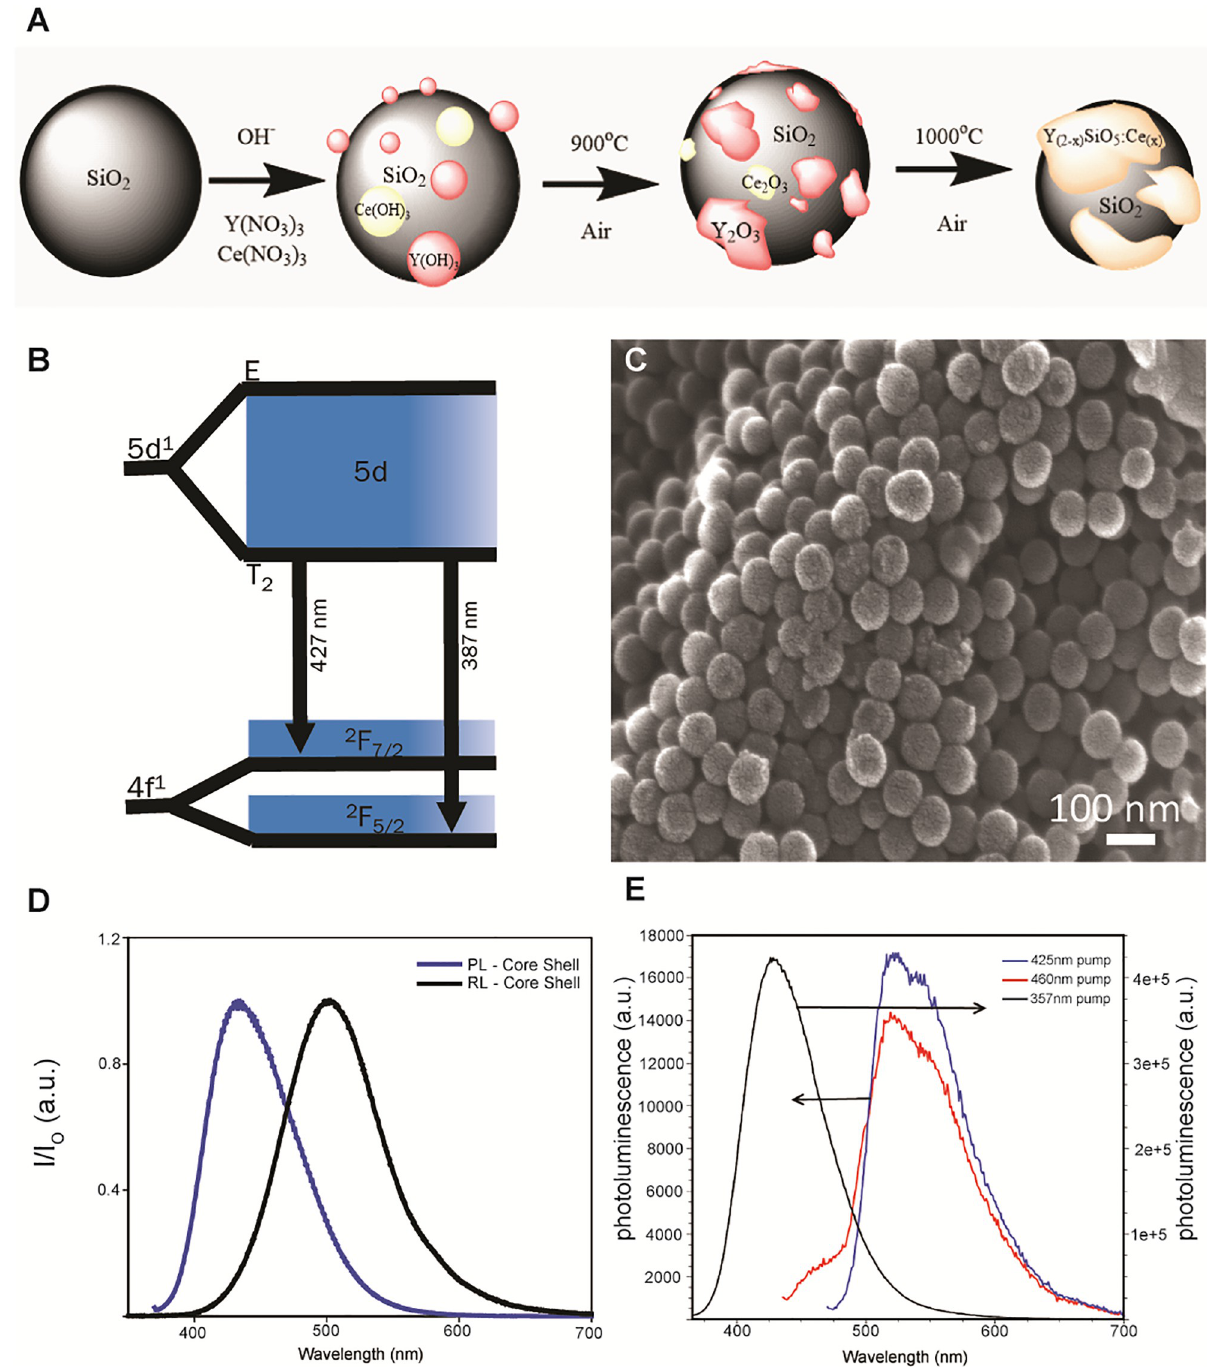
Fig 2. Generation and characterization of radioluminescent particles. A) Schematic of the development of Y2(SiO 4 )O:Ce using a core-shell method. B) Relaxation of cerium from it higher energy 5d state to its respective ground state of 2F7/2 and 2F5/2 in the Ce 1 site. C) Scanning electron micrograph of Y2(SiO 4 )O:Ce nanoparticles synthesized by the Sto¨ber process. D) Photoluminescence and radioluminescence of nano core-shell particulates irradiated by 360 nm and a broadband 40 KeV tungsten x-ray source, respectively. E) Photoluminescence spectra of sub-100 nm Y2(SiO 4 ) O/BSA/fluorescein nanoparticles in 1x PBS. A 100 μ L sample of a 31.4 mg/ml dispersion was placed in 2.90 ml 1x PBS. The normal fluorescein peak at ca. 525 nm is present when the excitation wavelength is 425 nm (red) or 460 nm (blue). Also presented is the system excited at 357 nm (black) to show that the Y2(SiO 4 )O component is